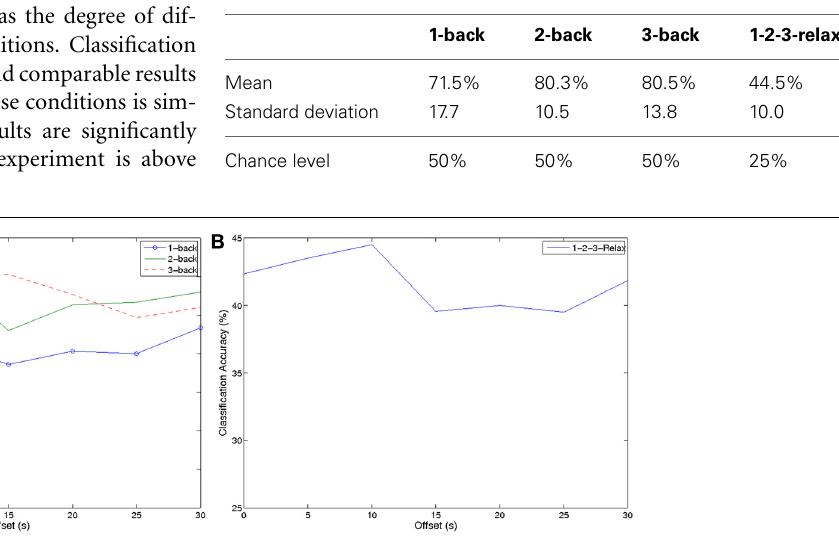
Frontiers in Human